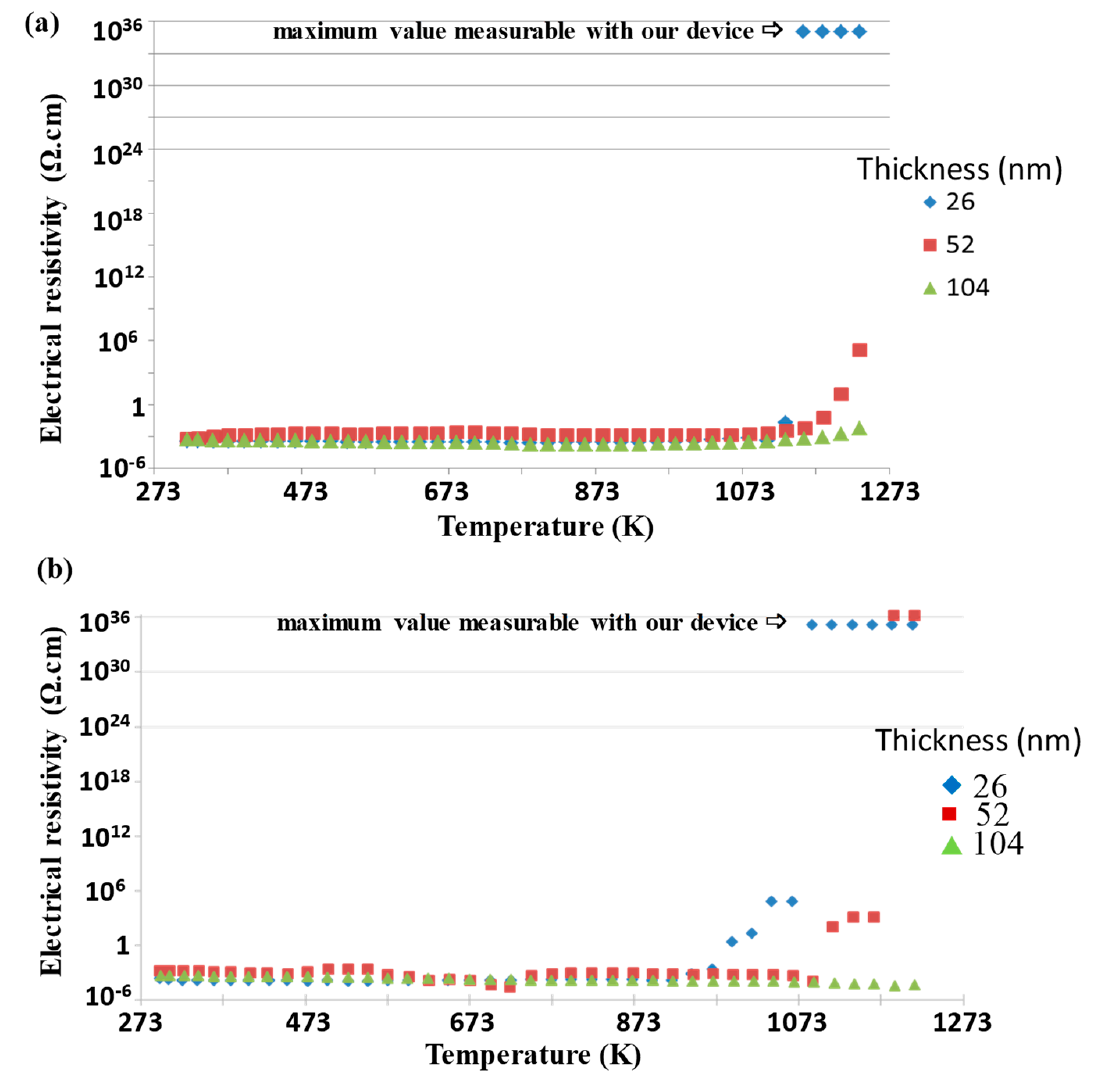
Figure 7. Resistivity measurements of Pt 3 Ti coatings as a function of the temperature and for three thicknesses ( a ) under static air and ( b ) under reductive atmosphere composed of 90% argon and 10% hydrogen.